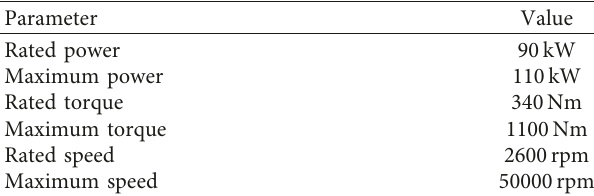
Table 2: Basic specifications of